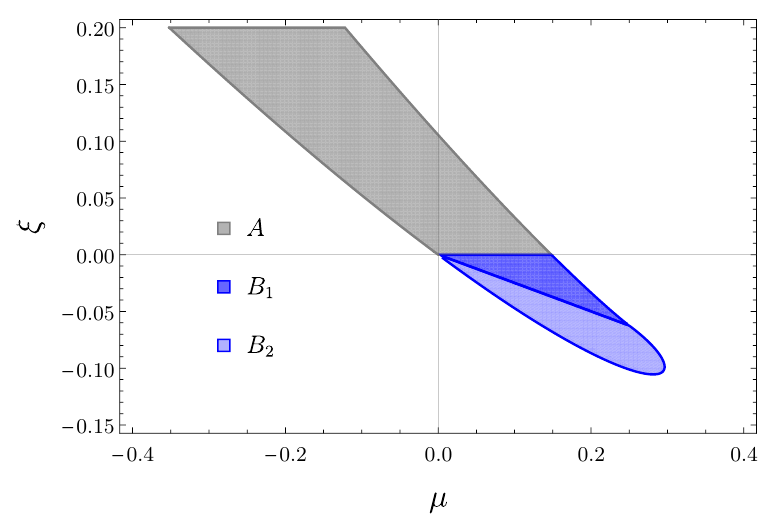
Figure 15 . Region of the parameter space for which there is at least one physical AdS